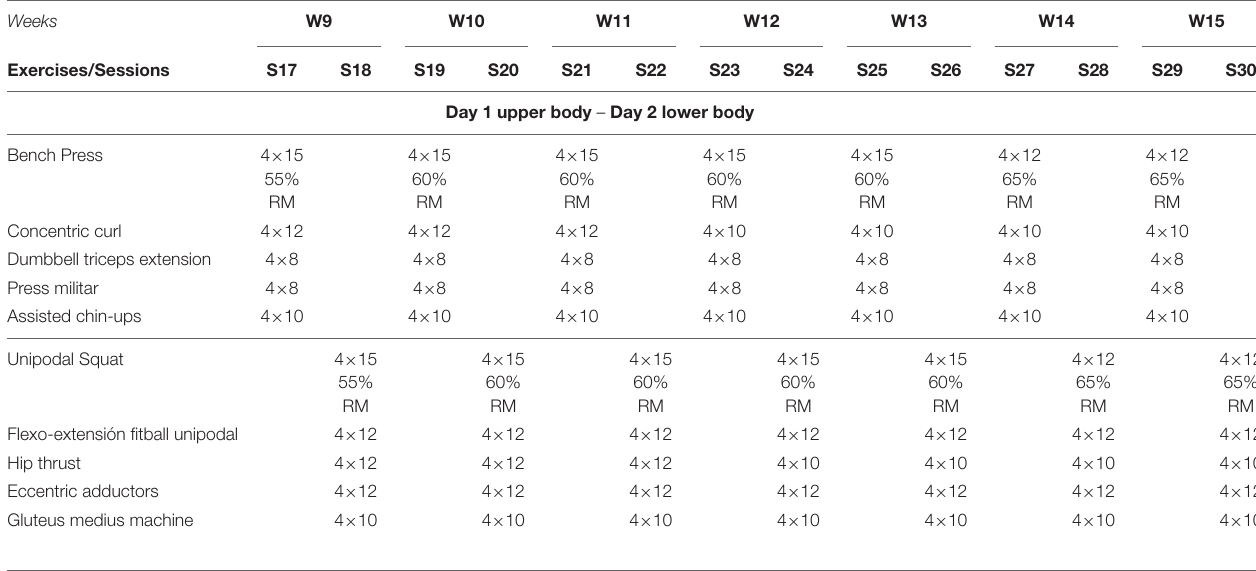
TABLE 2 | Phase 1(B): Overload